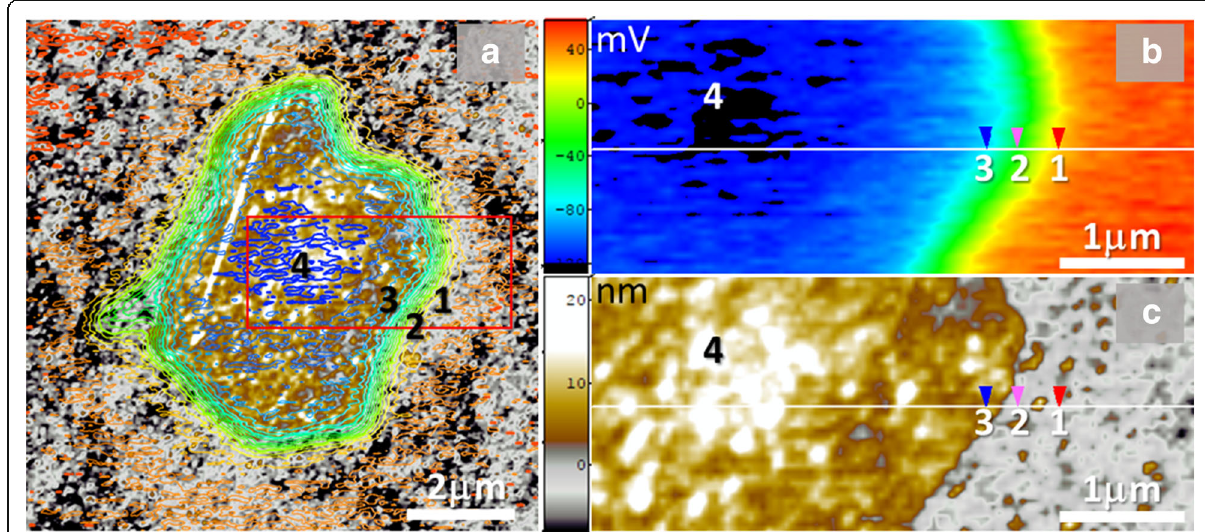
Fig. 9 Halo around flake. Topography map overlapped by corresponding SKPFM contour map of the GO flake on Ni substrate annealed at 140 °C for 15 min ( a ). Enlarged maps of surrounding halo are shown in ( b , c ). Numbers denote external (#1), external (#2), edge (#3), and intrinsic (#4)